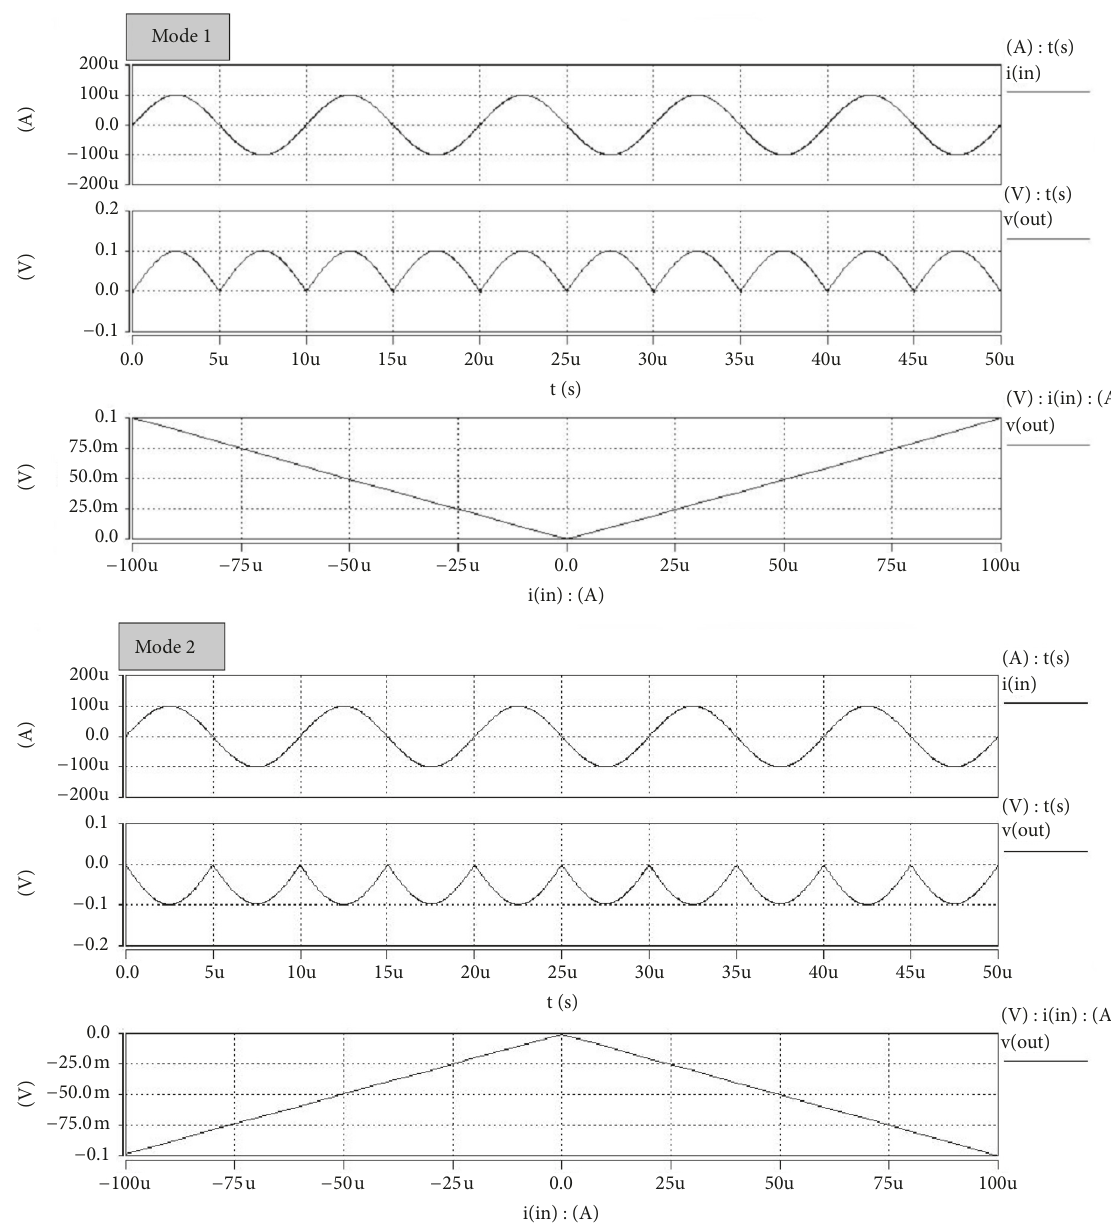
Figure 7: Simulation results of the input and rectified output waveforms and the corresponding input and output transfer characteristics of the circuit (Figure